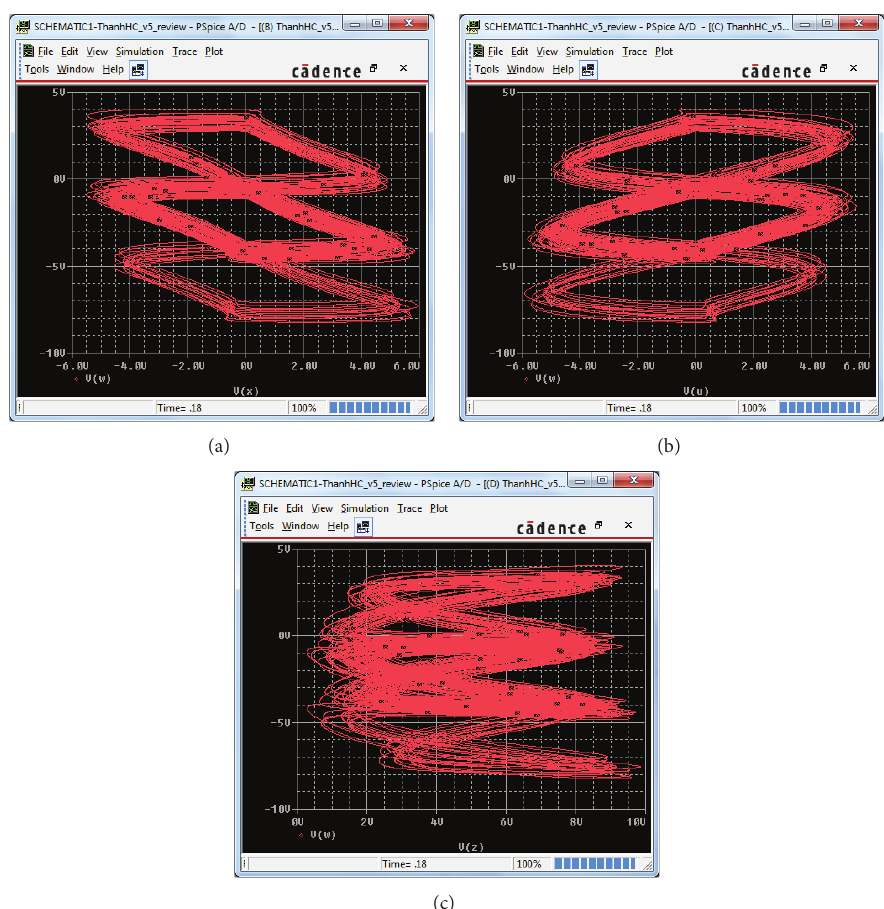
Figure 9: Hyperchaotic attractor of the designed electronic circuit obtained from OrCAD (a) in the 𝑥 − 𝑤 𝑚 plane, (b) in the 𝑢 𝑚 − 𝑤 𝑚 plane, and (c) in the 𝑧 − 𝑤 𝑚